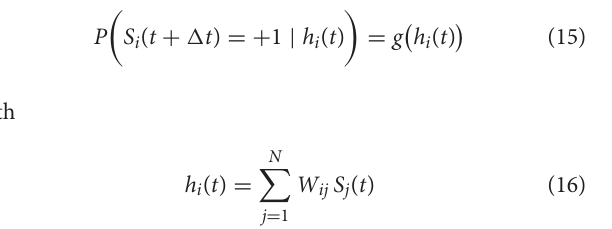
Figure 10 . For a neuron i , g gives the probability to reach